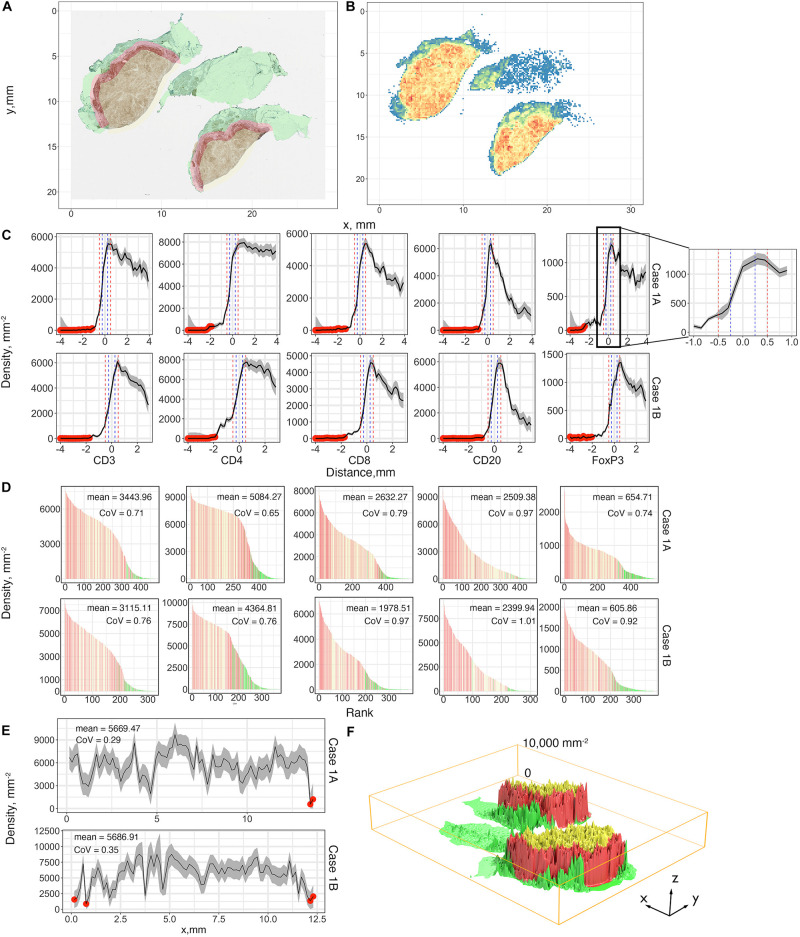
First-order variables statistics summary, Case 1, AB, is taken as an example for illustration. (A) Region characterization for WSI. Green: normal tissue (N); Red: invasive front (IF); Yellow: central tumor (CT). (B) CD4+ cell density visualized using heatmap with bin size = 0.15 mm. Color code: blue to red corresponds to low to high. (C) Cell density-distance profiles with a pop-up window for Cases 1A and 1B. Whole tissues are segmented into equidistant sections. Densities of different immune markers are calculated for each section and mapped with their distances to the invasive boundary, respectively. 95% confidence intervals are calculated upon the profile, and we use 80% of the density as the threshold to label those unreliable locations (red dots). Two definitions of IF are introduced here and are indicated as vertical lines, blue: width of 0.5 mm; red: width of 1 mm. (D) Densities of subregions are visualized using waterfall plots. For each slide, the densities are shown as bar heights, which are ranked from highest to lowest with colors corresponding to their locations. Color codes are consistent with (A). (E) The invasive front with thickness of 1 mm is sectioned along its horizontal direction, and the same process is repeated to construct the cell density-distance profile. (F) 3D visualization for the density of each subregion with location labels. Color codes are consistent with (A). See also Supplementary Material (Supplementary Figures S6, S7) for additional visualizations for Cases 2–5.